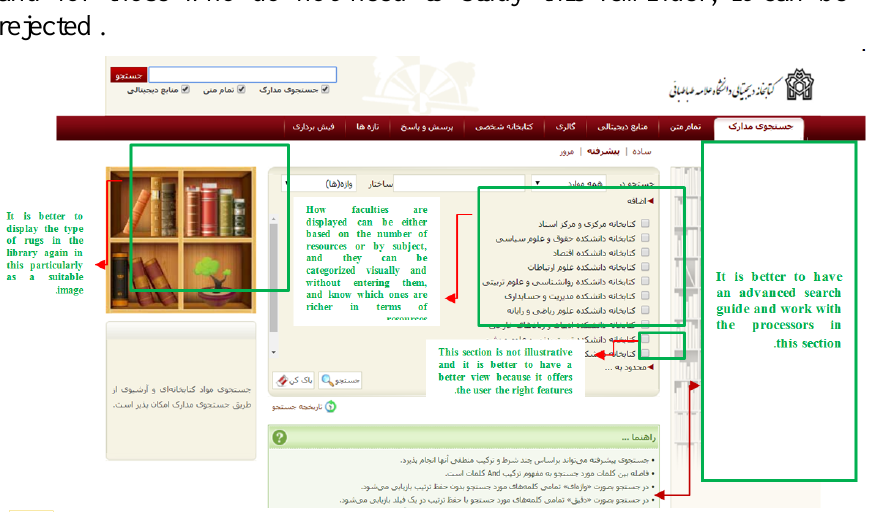
Figure 5- The proposed pattern of the digital library search page of Allameh Tabataba'i